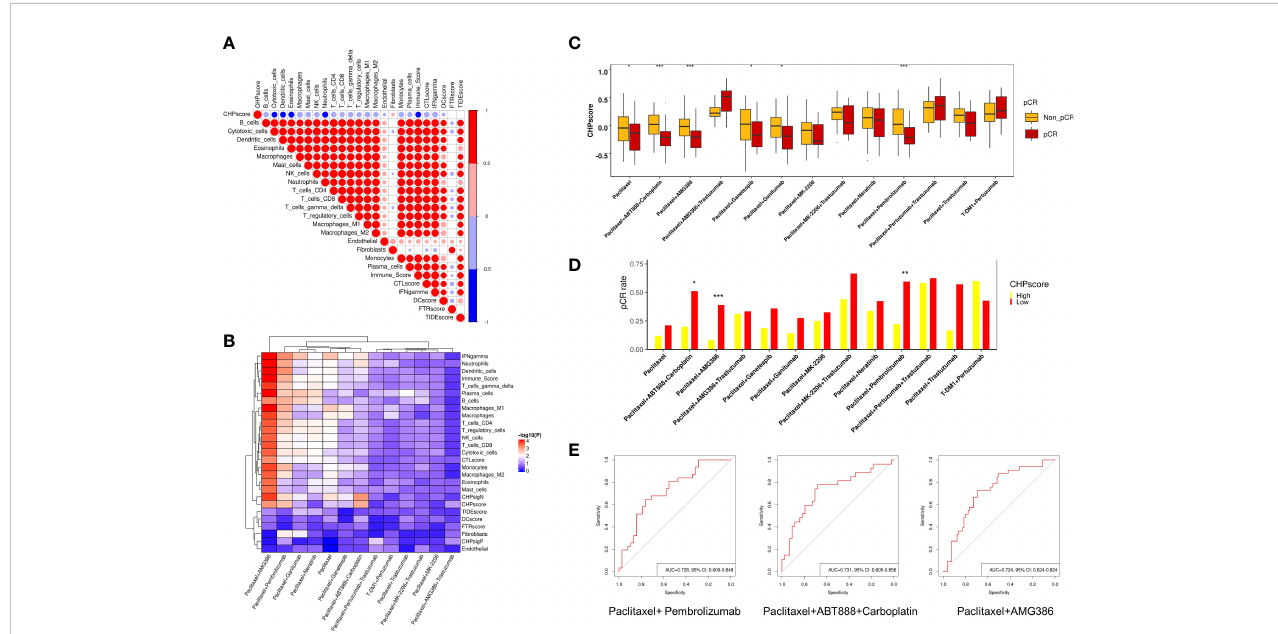
FIGURE 4 Role of CHP score in predicting the response to multiple-therapies in GSE194040 dataset. (A) Correlation coef fi cients between CHP score and the abundance of various immune cells or the expression of the immune signature in the GSE194040 dataset. (B) Correlation coef fi cients between the CHP score or speci fi c immune signatures with responses to different treatments in the GSE194040 dataset. (C) The pCR rate of different treatments in CHP score high and CHP score low groups in the GSE194040 dataset. (D) The CHP score for different treatments between responder and non-responder groups. (E) ROC curves show the ability of the CHP score to predict the response to Paclitaxel+ Pembrolizumab, Paclitaxel+ABT888+Carboplatin, and Paclitaxel+AMG386. *p < 0.05, **p < 0.01, ***p <